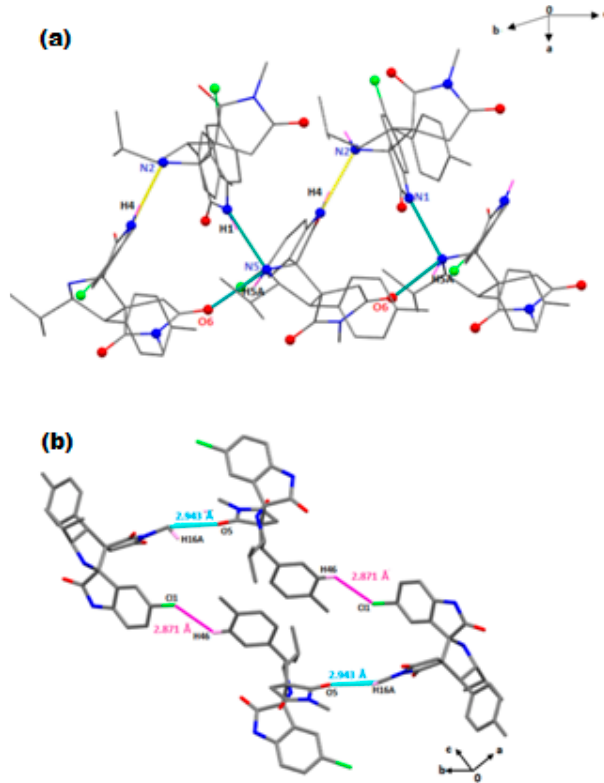
Figure 4. ( a ) Representation of the N-H····N and N − H····O bonding between two adjacent molecules of 5b . Intermolecular interactions contacts are shown as dashed lines. ( b ) Presentation of the inter- molecular C–H··· Cl and C–H··· O contacts occurring in 5b